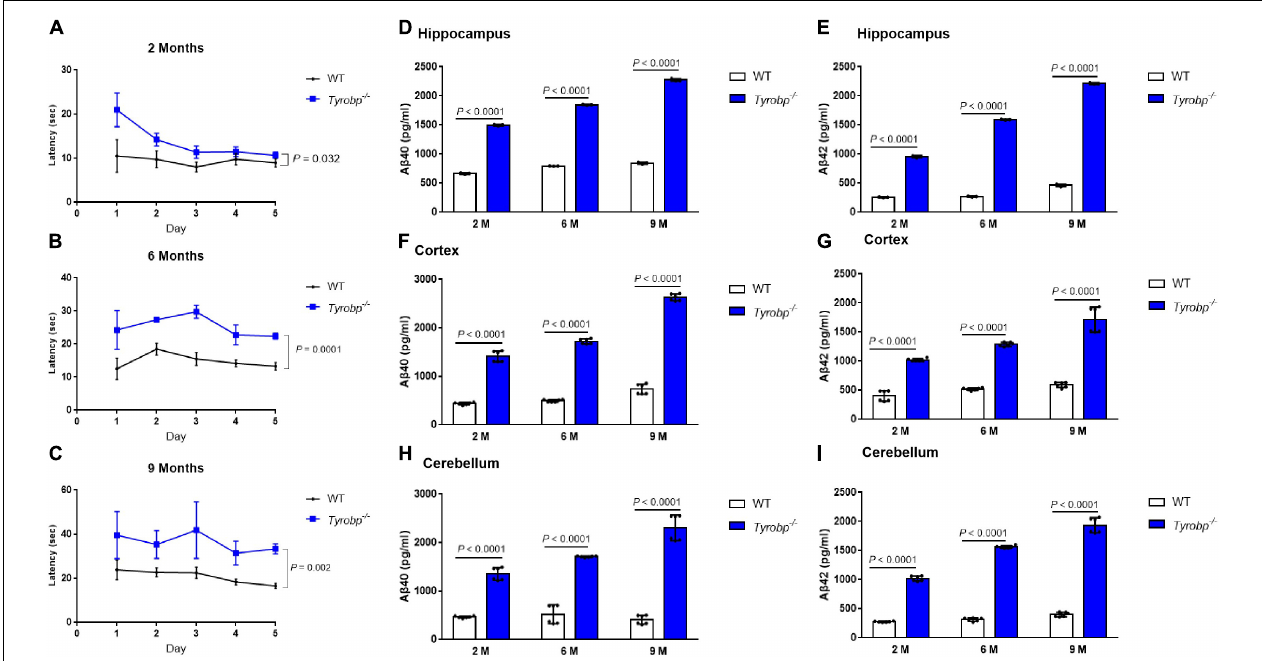
FIGURE 2 | Performance in the Morris water maze and levels of soluble A β 40 and A β 42 in WT and Tyrobp − / − mice. (A–C) Escape latency of WT and Tyrobp − / − mice aged 2, 6, or 9 months. (D,E) Levels of soluble A β 40 and A β 42 in hippocampus of WT and Tyrobp − / − mice aged 2, 6, or 9 months (M), as detected by ELISA. (F,G) Levels of soluble A β 40 and A β 42 in cortex of WT and Tyrobp − / − mice aged 2, 6, or 9 months (M), as detected by ELISA. (H,I) Levels of soluble A β 40 and A β 42 in cerebellum of WT and Tyrobp − / − mice aged 2, 6, or 9 months (M), as detected by ELISA. Data are mean ± SEM (six mice per group). Differences were assessed for significance using two-way ANOVA for repeated measures, followed by Tukey’s post hoc